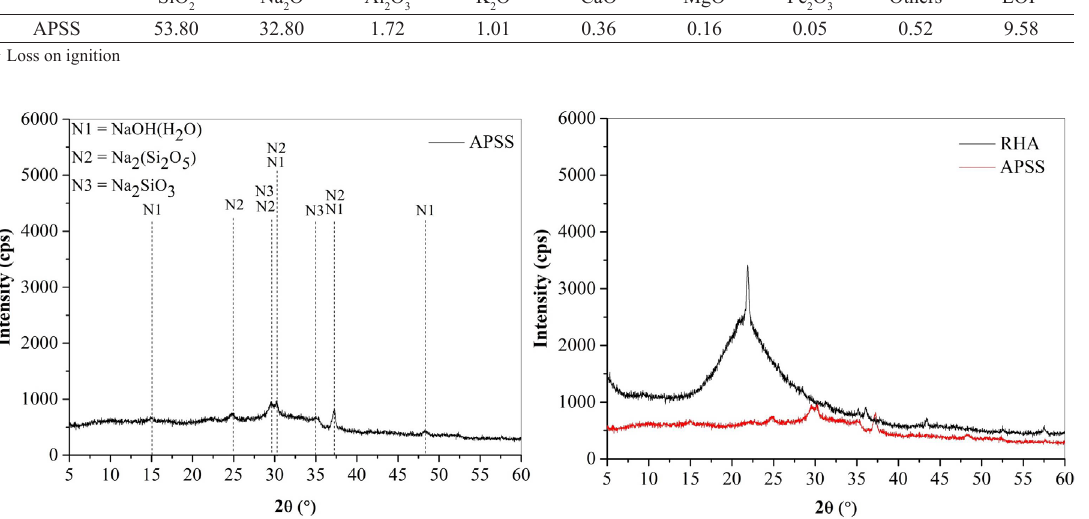
Table 3. Chemical composition of alternative sodium silicate (APSS) in powder.